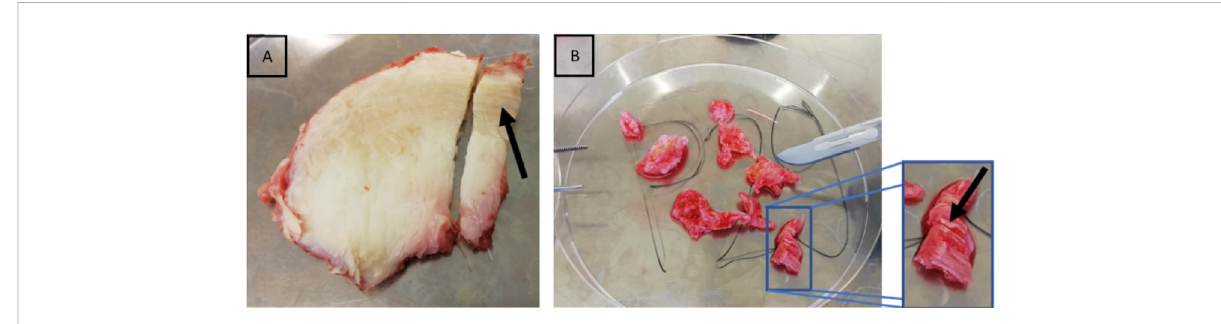
FIGURE 2 Selection of anulus fi brosus from intraoperatively obtained tissue. Lamellar structure of the anulus fi brosus. The black arrows point at the lamellar structure of the anulus fi brosus in bovine (A) and human IVD samples (B) . This lamellar structure can already easily be recognised by the naked